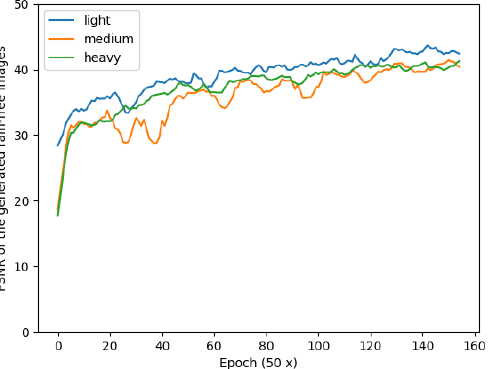
Figure 9. PSNR of the reconstructed rain-free images from light, medium, and heavy rainy